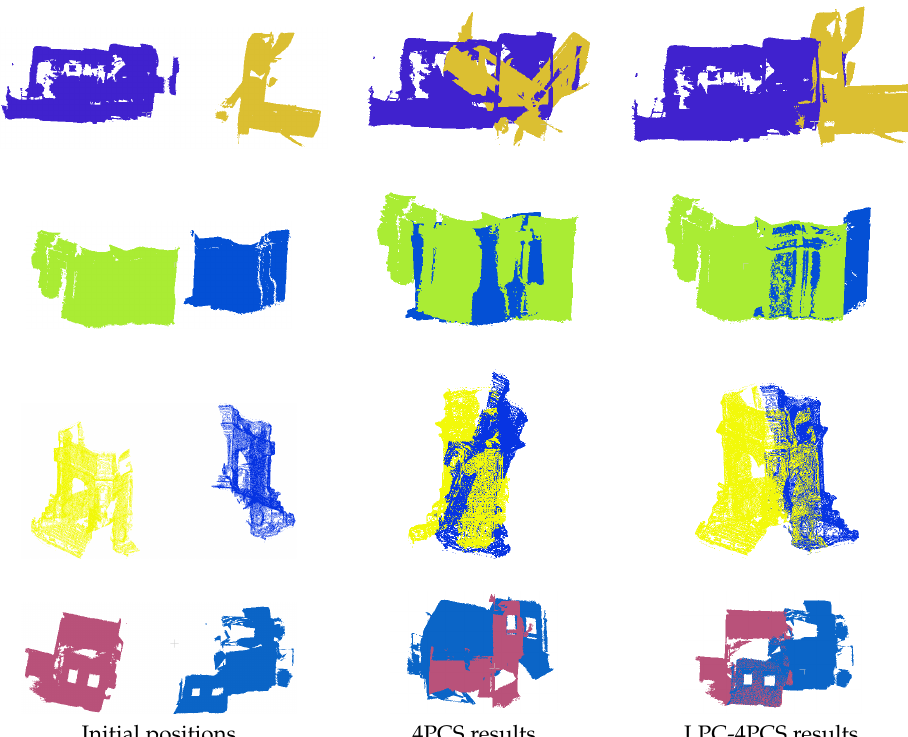
Figure 8. Result of point cloud alignments on Camertronix dataset, CharlotteBürgerturm dataset, Valentino dataset and, Buro dataset from top to bottom, respectively. First column: initial position of the point clouds; Second column: the results of the alignments with 4PCS, third column: the results of the alignments using